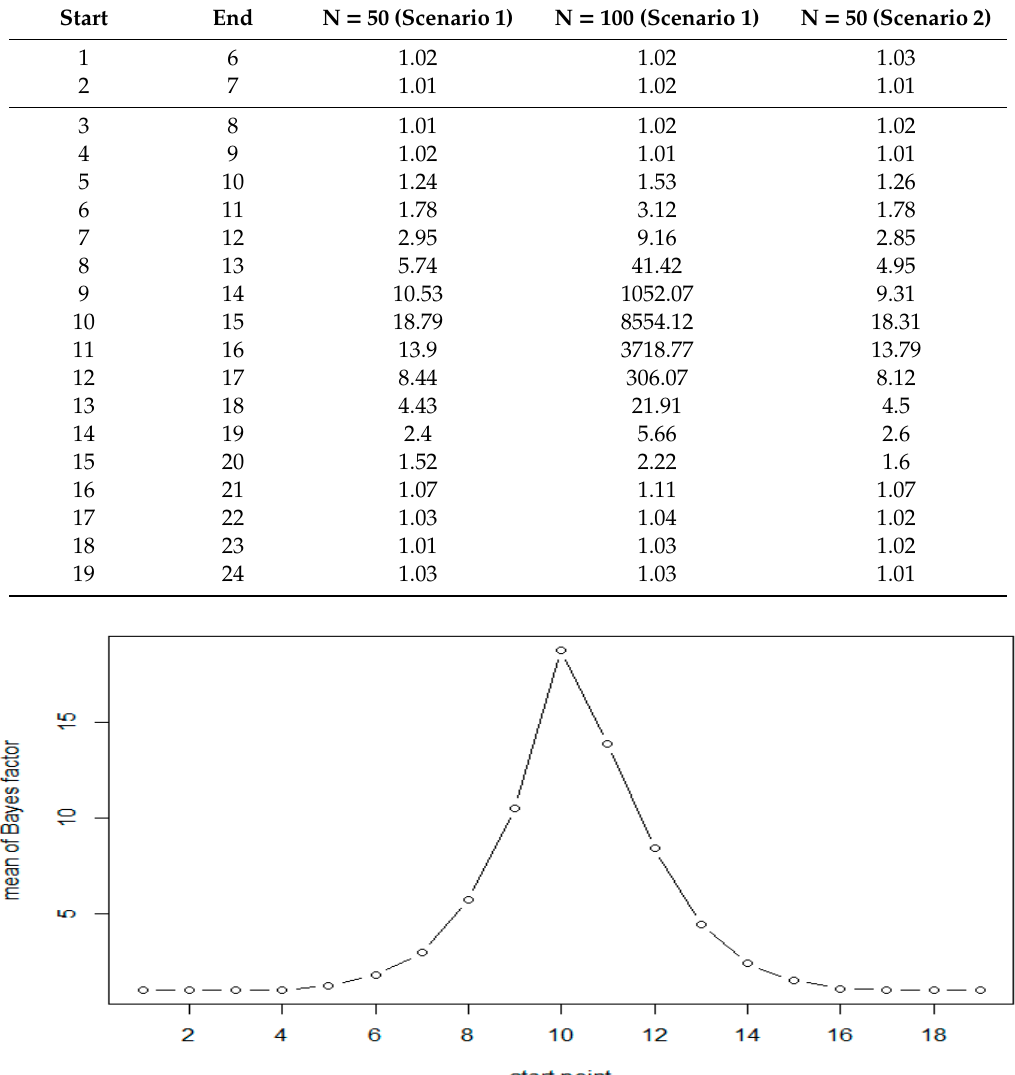
Table 2. Mean Bayes factors at each CpG site, based on simulation studies.